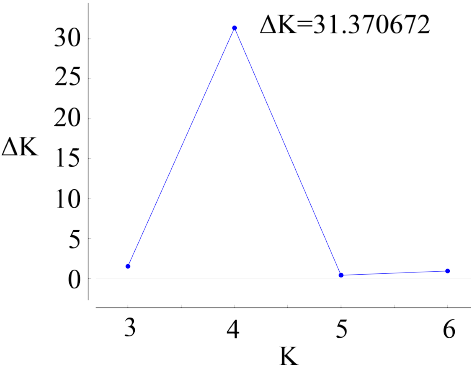
Figure 4. The value of delta K (averaged across 8 runs) obtained from STRUCTURE software